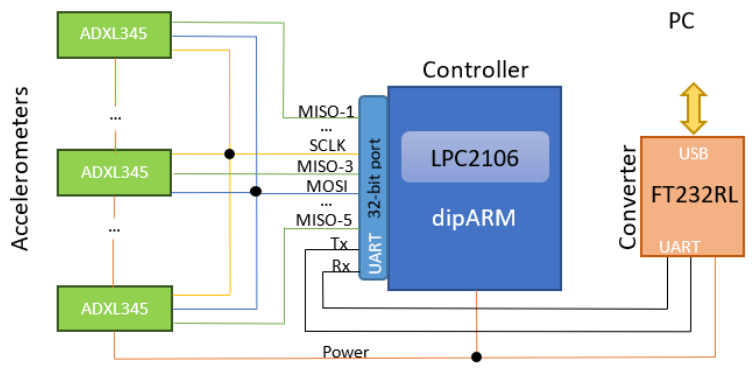
Figure 8. A schematic diagram of the measurement system architecture.